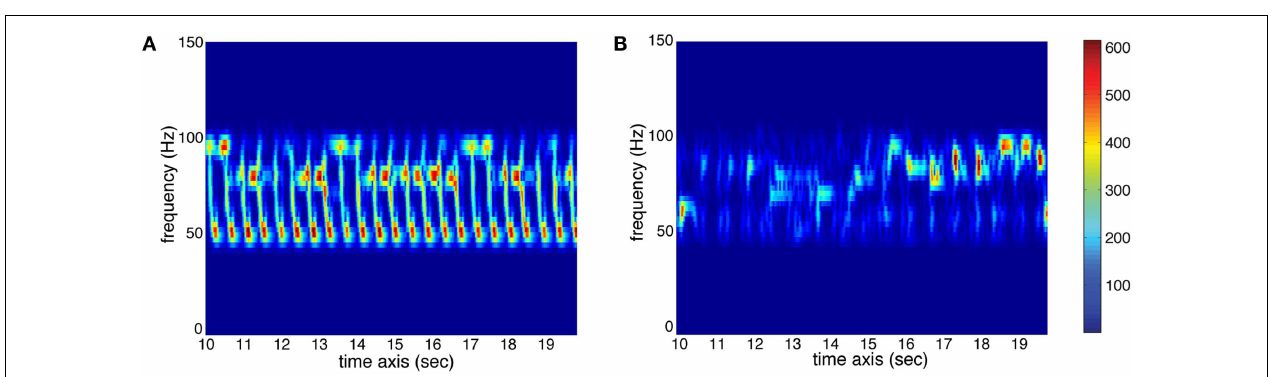
represents low energy; see color bar) resulting in high value for Sub-Band Flux (stimulus 26, see Appendix). (B) Low amount of temporal change resulting in low Sub-Band Flux (stimulus 5, see Appendix).